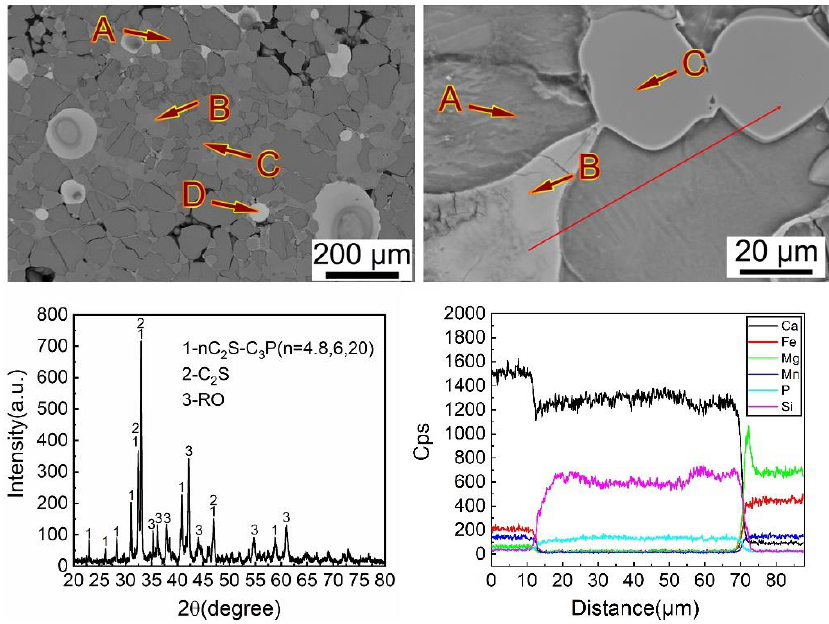
Figure 2. Results of the SEM image, XRD analysis and line scan of decarburization slag.